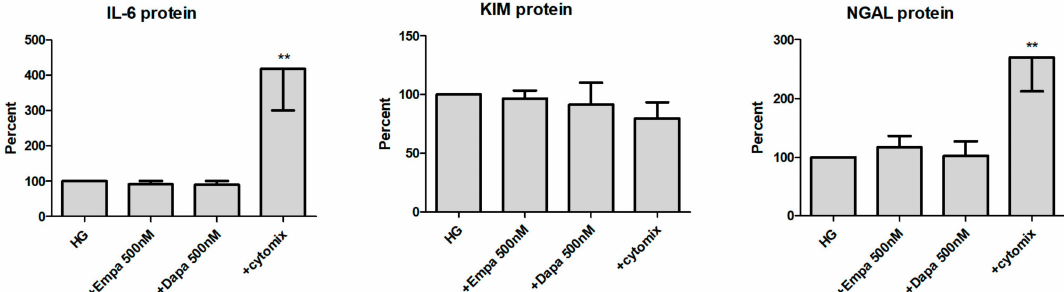
Figure 7. E ff ect of empagliflozin and dapagliflozin on the release of pro-inflammatory and injury proteins. Cells were grown in a 24-well plate until confluence, serum depleted for 2 h and stimulated in HG for 48 h. Supernatants were then harvested and quantified using commercially available immunoassays (optical density 450 / 620 nm, calculated as percent in relation to the control (HG), mean ± SD). A mixture of pro-inflammatory cytokines (cytomix) was used as a positive control. (** p < 0.01 versus HG, IL-6 n = 6, KIM-1 and NGAL n =